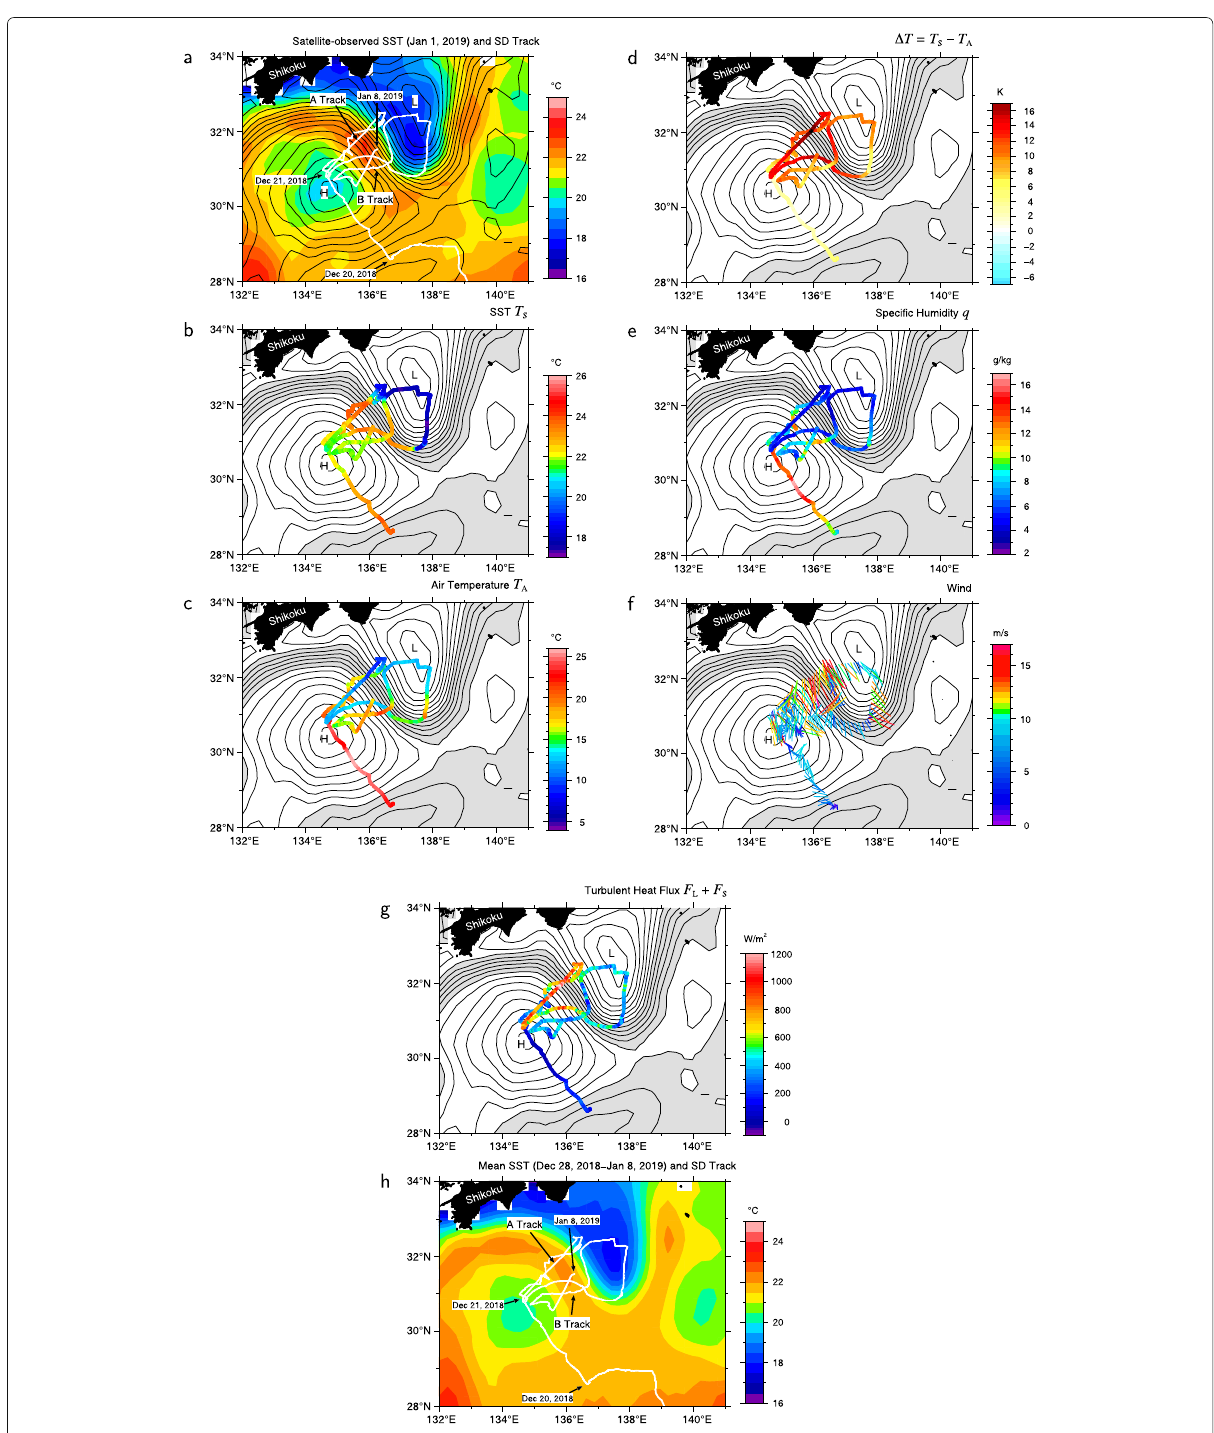
Fig. 3 Plots of a satellite-observed sea surface temperature (SST), b Saildrone-observed SST, c air temperature, d air-sea temperature difference, e specific humidity, f wind vector, g turbulent (latent plus sensible) heat fluxes on the Saildrone track and altimetric sea surface height (SSH, contours) on January 1, 2019, and h satellite-observed SST averaged from December 28, 2018, to January 8, 2019. In a and h , the Saildrone tracks are illustrated by thick white line. The SSH contour interval is 10cm and, except for a , gray shaded areas indicate SSH values between 90 and